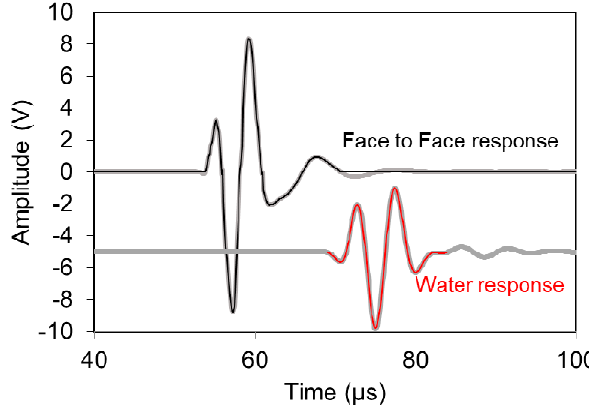
Figure 6. Face-to-face sensor and water response, showing the whole waveforms (thick lines), as well as the cleaned waveform (thin lines) used for analysis after zero-padding.